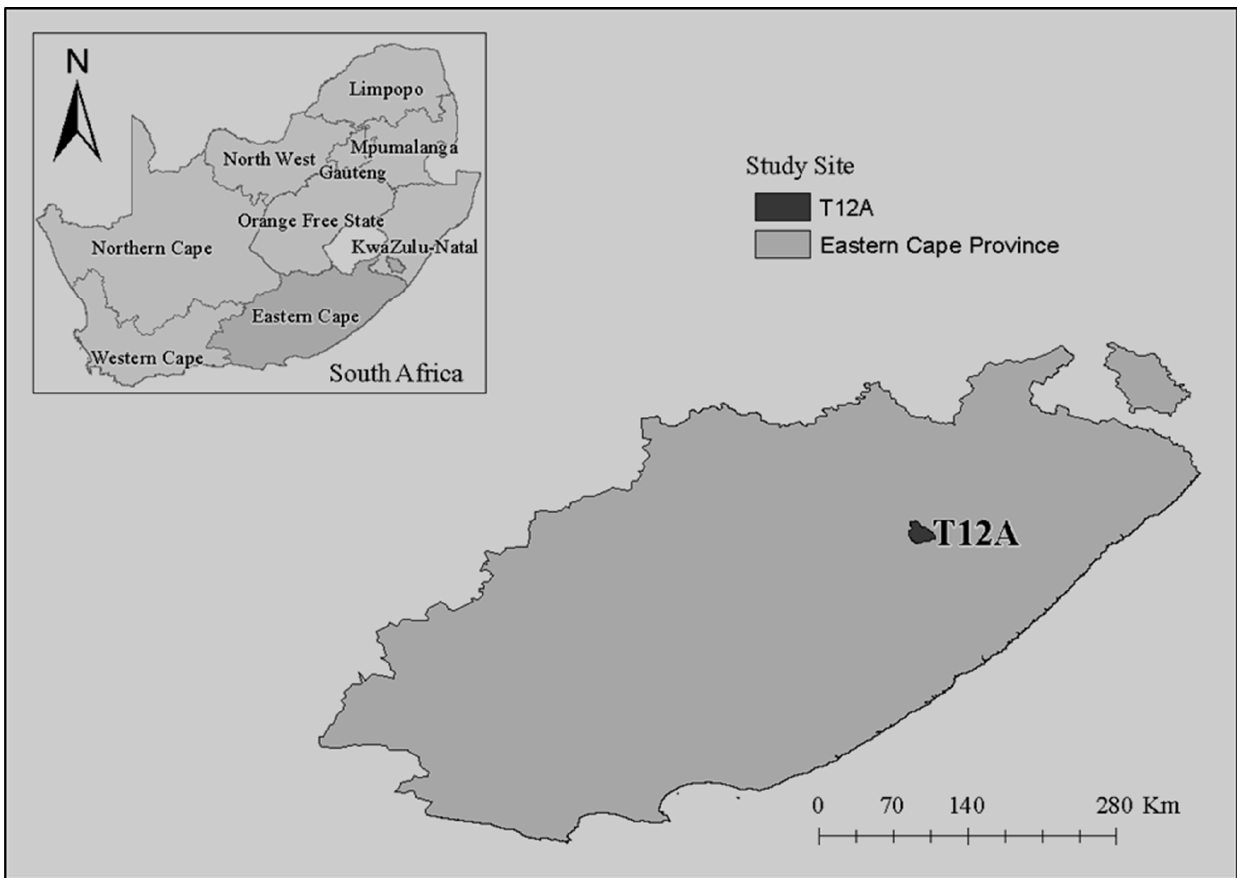
Figure 1. Map of the study site where animal grazing distribution occurred in the village of Mgwalana (T12A).